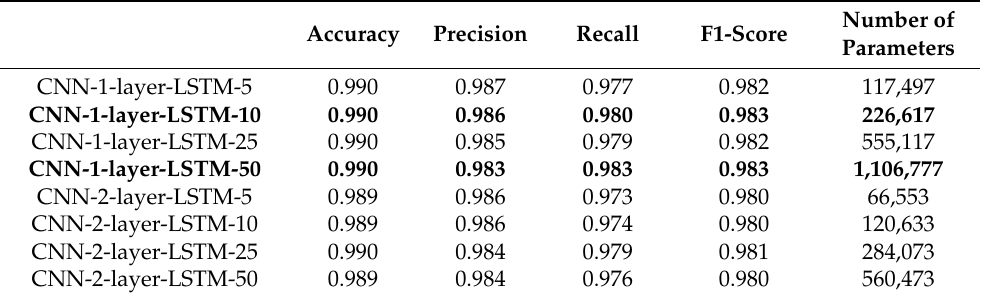
Table 5. Results from the CNN-LSTM models of various configurations using the architecture depicted in Figure